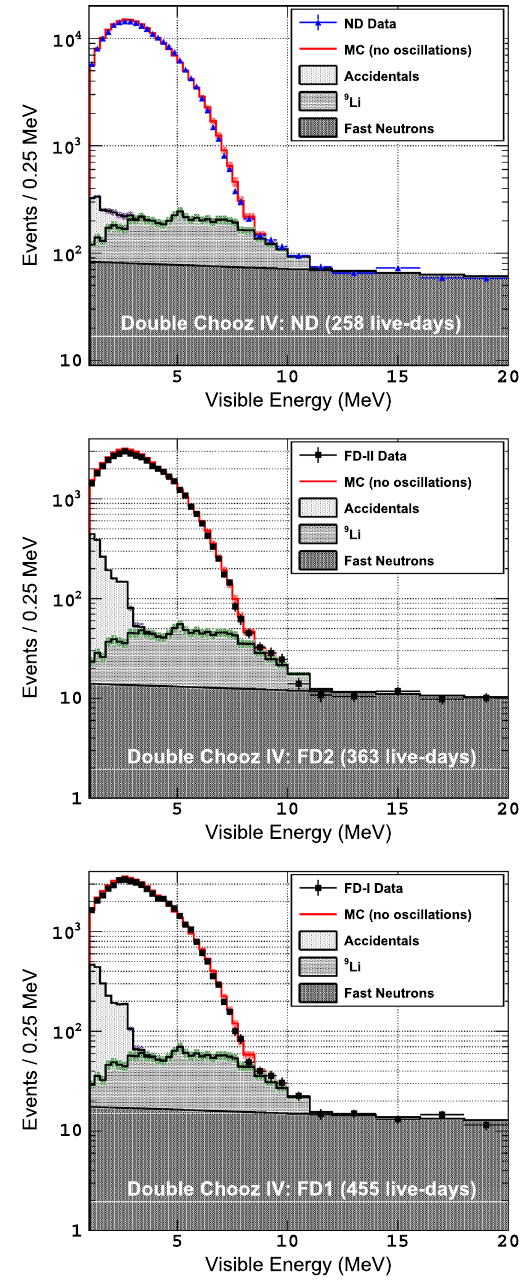
Fig. 3 Visible energy distributions of the prompt events in the final data set. The ND (top) data is plotted with blue triangles and the FD- II (middle) and FD-I data are displayed as black squares. The different backgroundmodelcontributionsareshownasstackedhistogramswhere green indicates the long-lived isotopes (lithium) background, blue the accidental background and gray the fast neutron and stopping muon background. The red line indicates the total prediction from reactor models assuming no oscillations including the